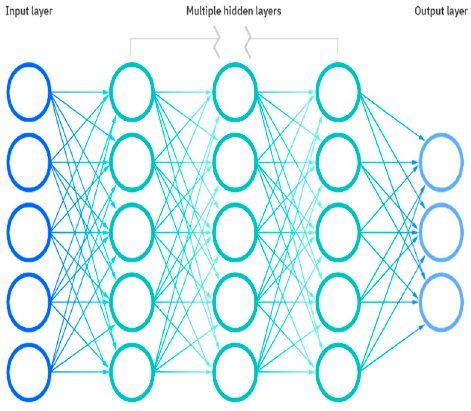
Figure 1. Neural Figure 1. Neural Network.